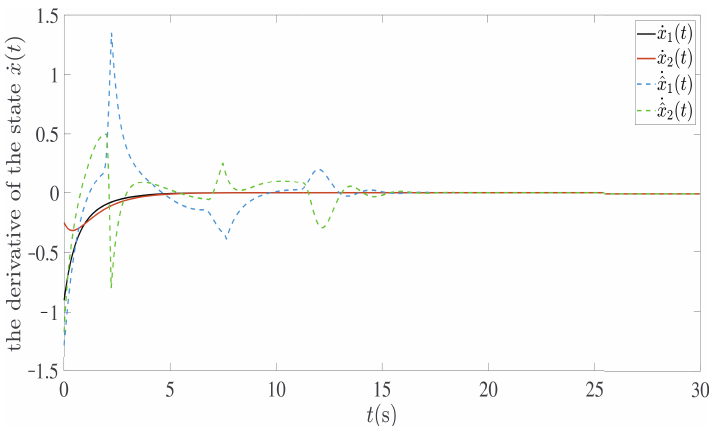
Figure 6. The estimated error curves of the states.